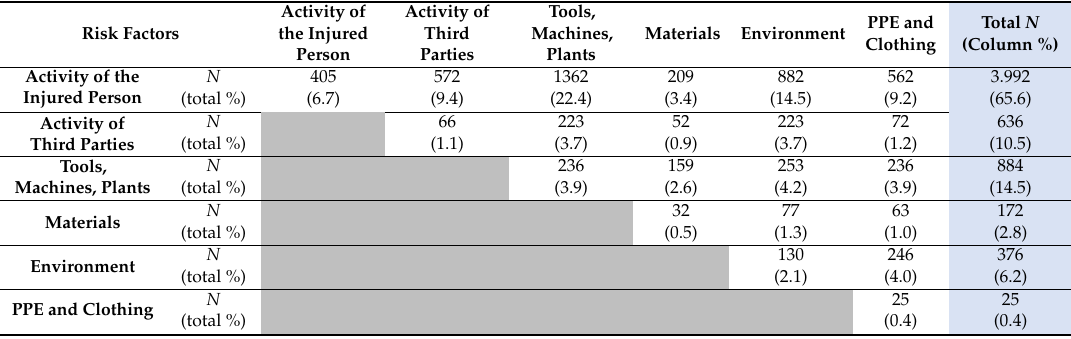
Table 8. Frequencies of combination of two risk factors of occupational fatal injuries. Number (N), percentage (%). PPE, Personal protective equipment.